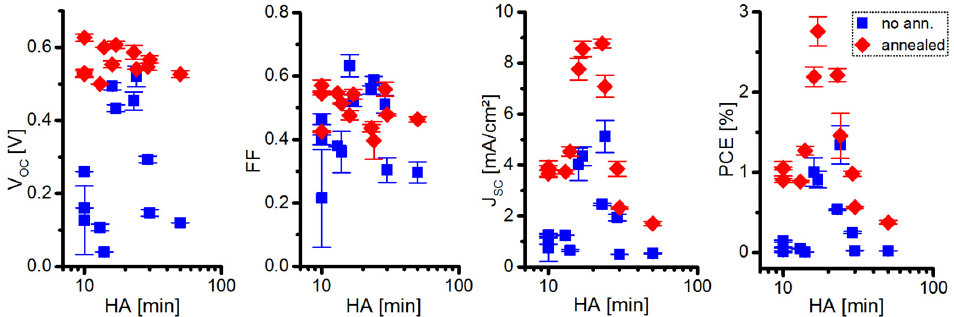
Figure 7. Differently long HA washed CdSe QDs (100:2:2) exhibit different performances when incorporated inside hybrid BHJ solar cells both without annealing and with 10 min of thermal annealing at 145 °C (results obtained from 36 cells).